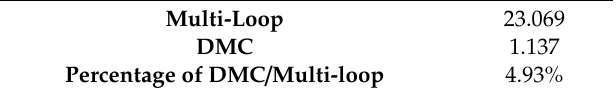
Table 3. Squared error sum comparison of AFR in 600 MW plant.